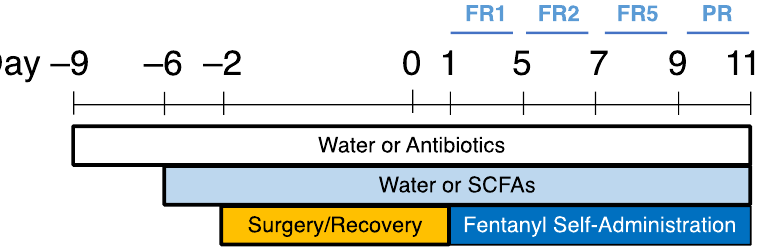
Figure 7. Experimental timeline for short-chain fatty acid (SCFA) supplementation and fentanyl self-administration. Animals were provided drinking water plus antibiotics or drinking water only for 3 days. SCFA or vehicle (water) was added to the treatment and rats were maintained on their assigned treatment throughout the entire experiment. Following one week of antibiotic treatment, animals were implanted with intravenous catheters and given 2 full days to recover from surgery before starting self-administration. Animals self-administered fentanyl at fixed ratio (FR) 1 for 5 days, FR2 for 2 days, FR5 for 2 days, and progressive ratio (PR) for 2 days, for 11 days total. 16S Sequencing: Fecal samples from animals were collected in individual 1.7 mL Ep-